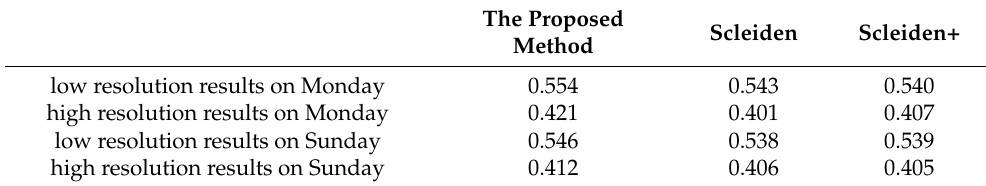
Table 5. Modularity values of the spatial communities identified by the proposed method, Scleiden, and Scleiden+ during afternoon rush